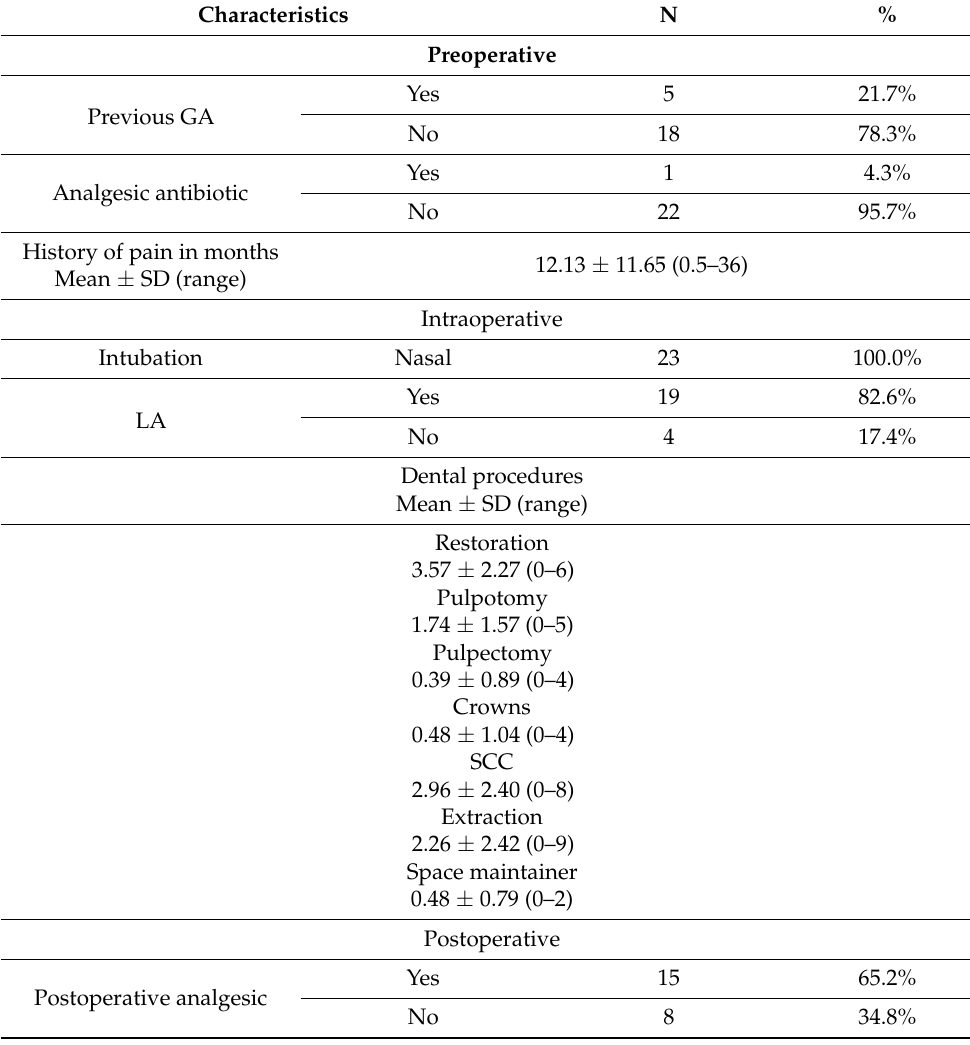
Table 3. Questions asked of